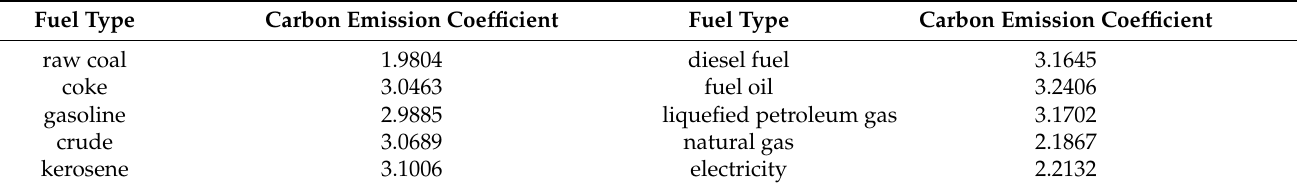
Table 2. Carbon emission coefficients of various energy